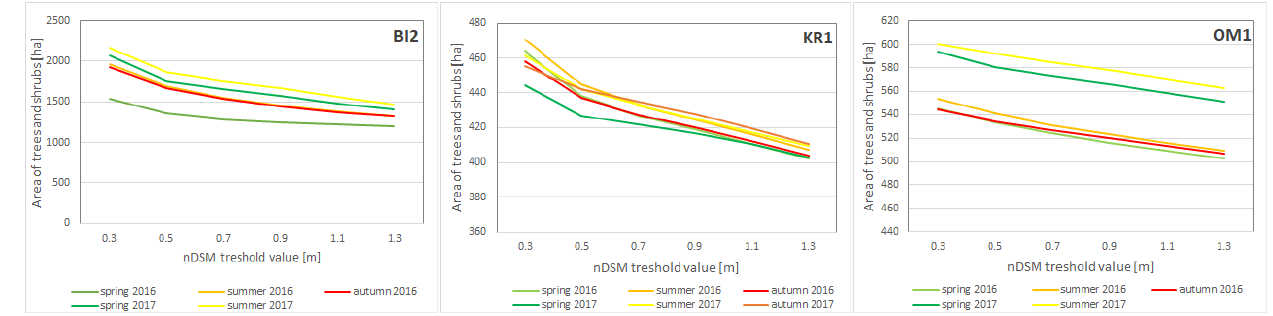
Figure A1. The comparison of tree and shrub spatial extents obtained for the three research areas (BI2, KR1, OM1). The results differ for each data acquisition campaign and nDSM threshold value (nDSM obtained using newly acquired LiDAR data). Table A1. The accuracy assessment report of shrubs and trees extent determination (nDSM obtained using a dense image matching algorithm on archival aerial photos), OM1 study